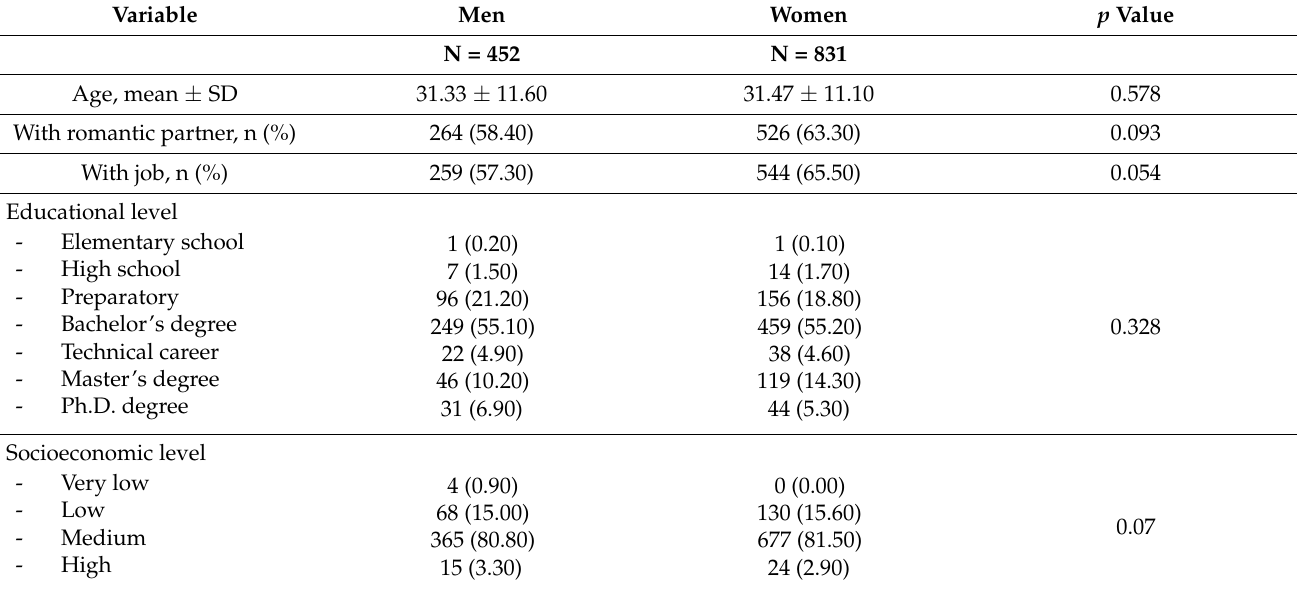
Table 1. Sociodemographic variables in the studied